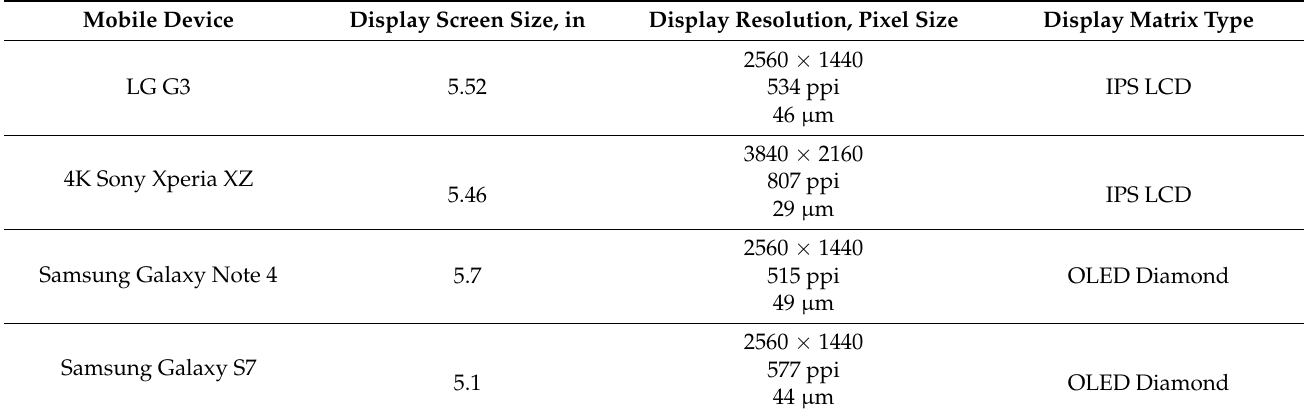
Table 2. Characteristics of mobile phones.